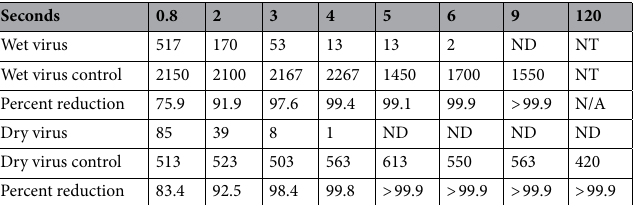
Table 1. Reduction in viral titer (PFU/ml) at different irradiation times. PFU/ml plaque-forming units per milliliter, ND not detected, NT not tested, N/A not applicable.